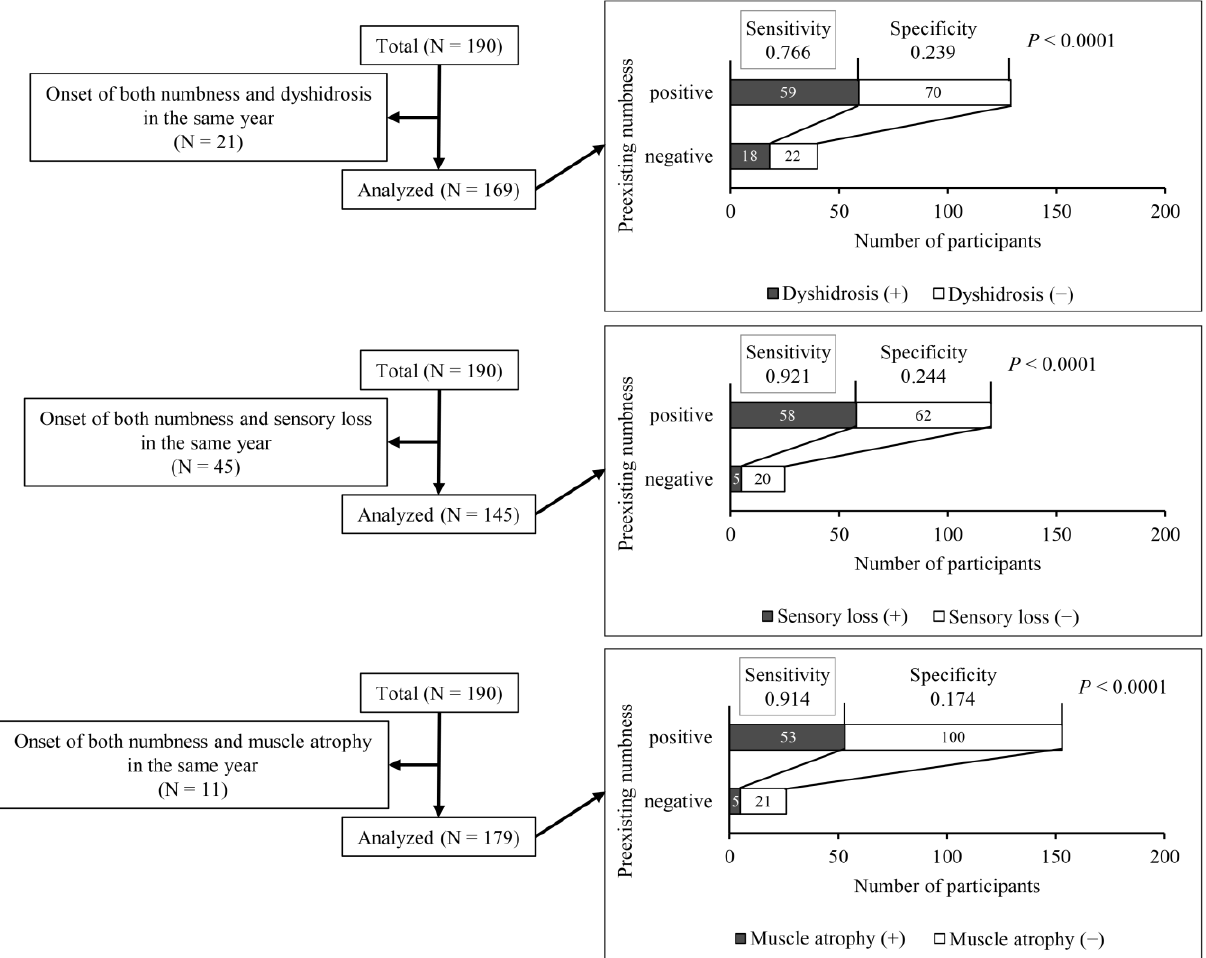
Figure 3. The relation between numbness and other subsequent neurological symptoms, specifically dyshidrosis, sensory loss, and muscle atrophy, in participants who had numbness and at least one other neurological symptom. Sensitivity and specificity were analyzed. Significant differences were analyzed by the McNemar test.